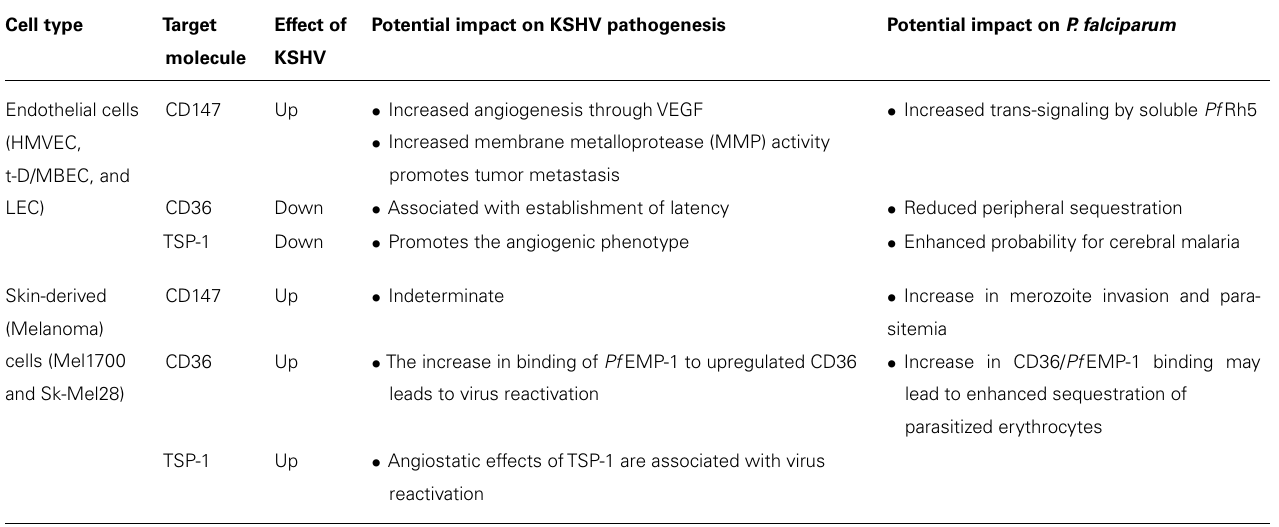
Table 1 | Summary of the effects of KSHV on CD36 and CD147 expression and signaling, and examples of their potential impact on KSHV and P. falciparum disease pathogenesis. Cell